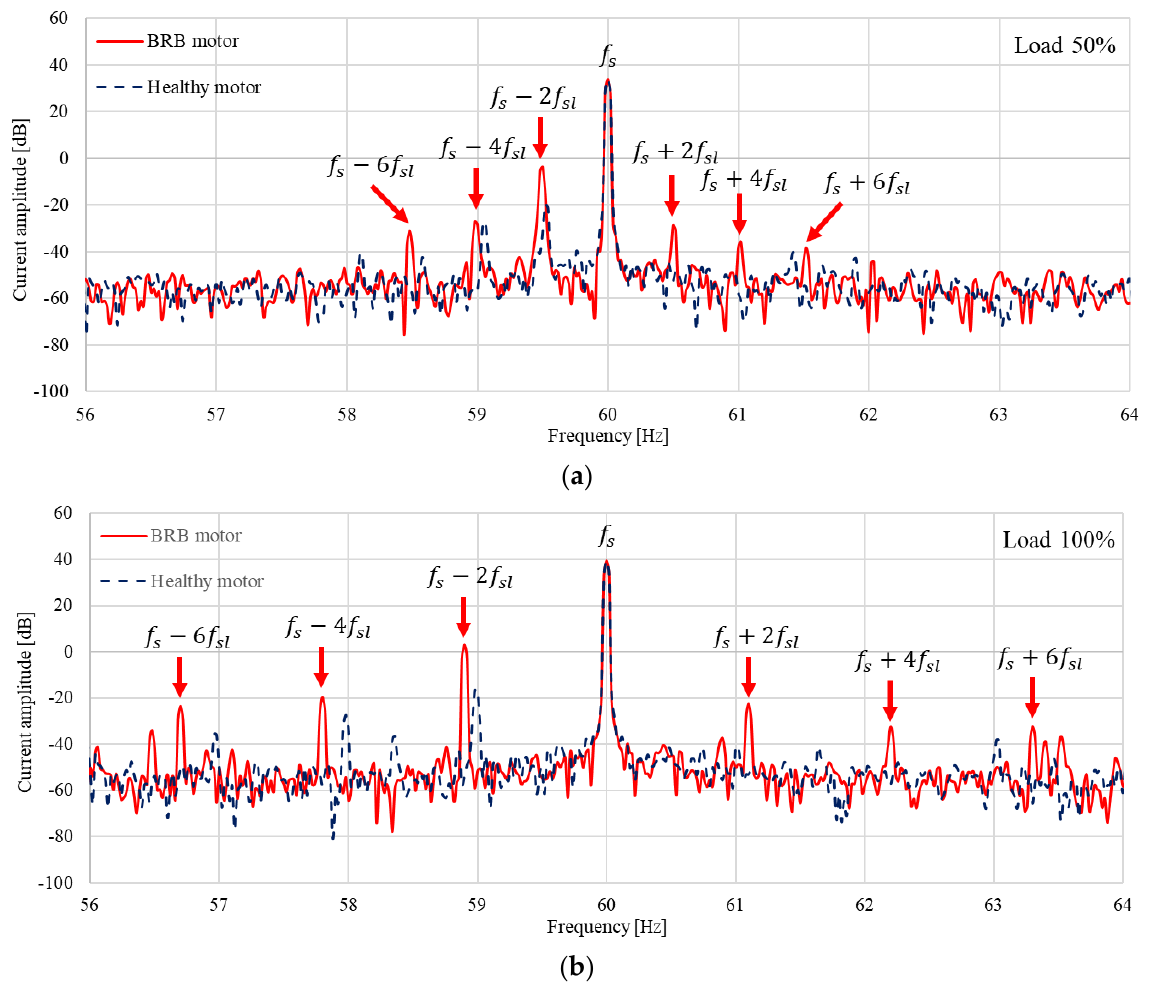
Figure 2. Frequency spectrum of phase current with BRB fault and healthy induction motor at ( a ) 50% and ( b ) 100% of rated load.